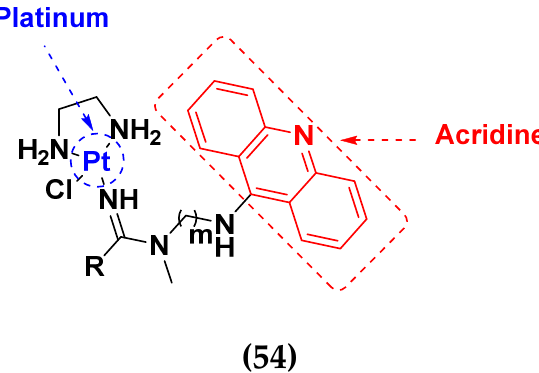
Figure 62. Structure of Platinum − acridine hybrid derivatives ( 54 ). Table 49. In vitro cytotoxic activities of Platinum − acridine hybrid compounds 54 ( a – e ).